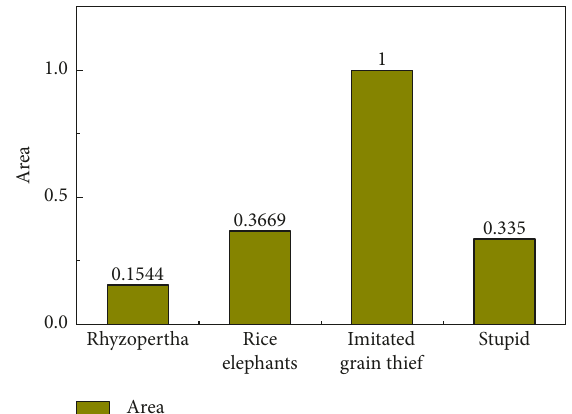
Figure 2: Normalized eigenvalue (area) of identified pests.